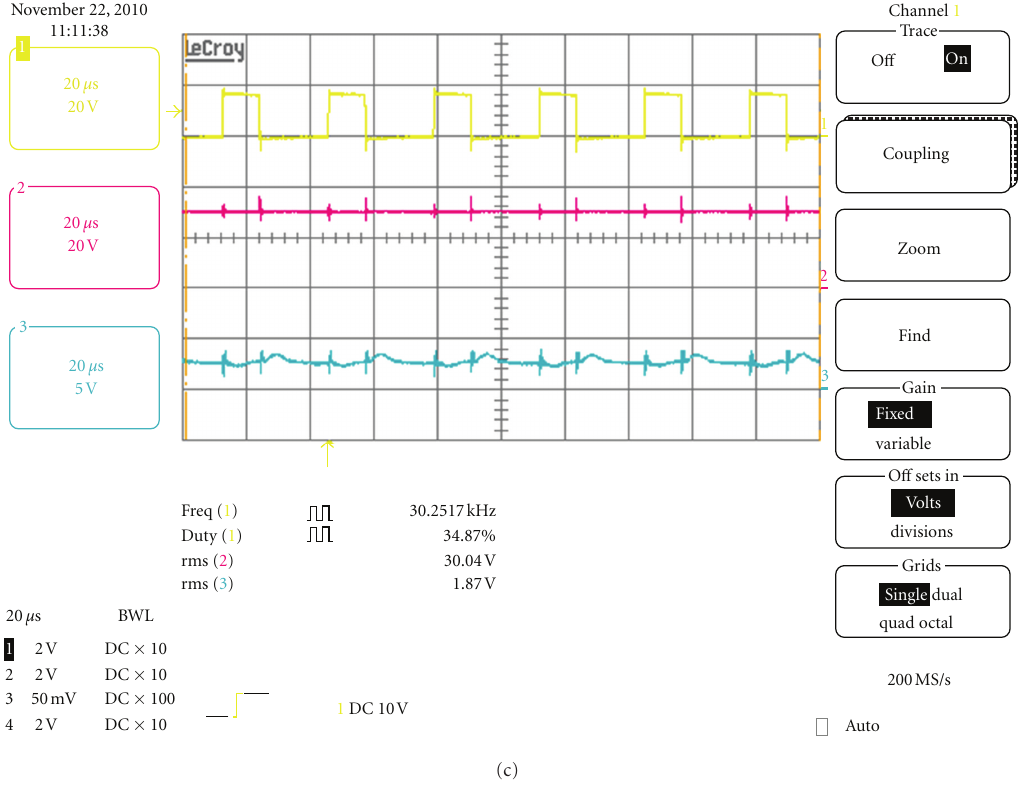
Figure 9: (a) The wave forms of 21V and 2.54 A at Point A. (b) The wave forms of 25V and 2.44 A at Point B. (c) The wave forms of 30V and 1.87 A at Point